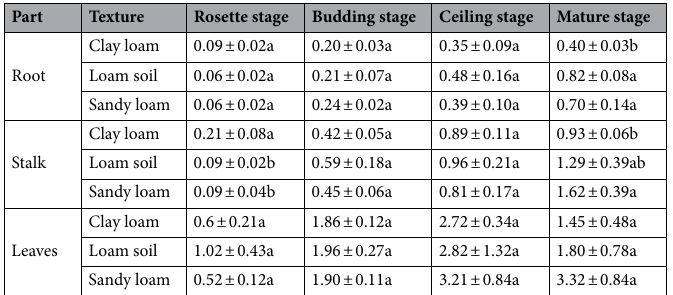
Table 2. The N accumulation of various flue-cured tobacco organs at different growth stages (g/plant). Values followed by different letters in a column are significant among treatments at the 5% level.